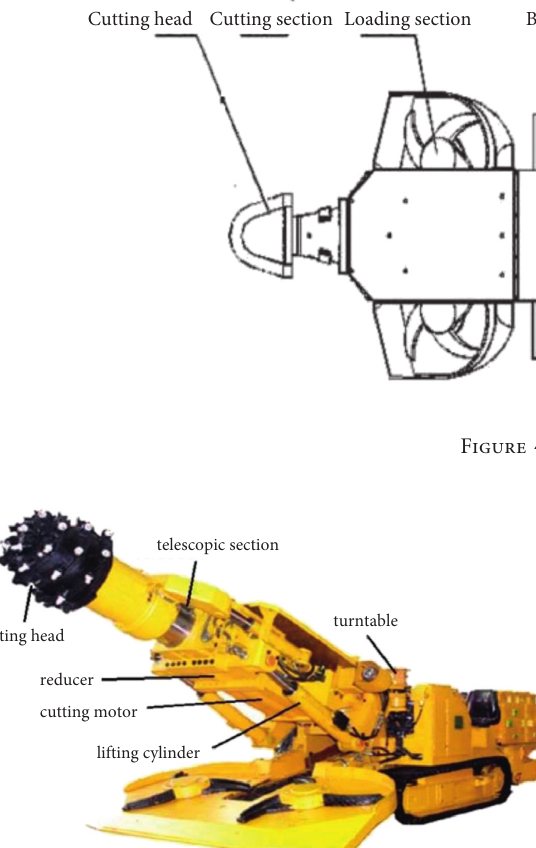
Figure 5: Cutting section of the